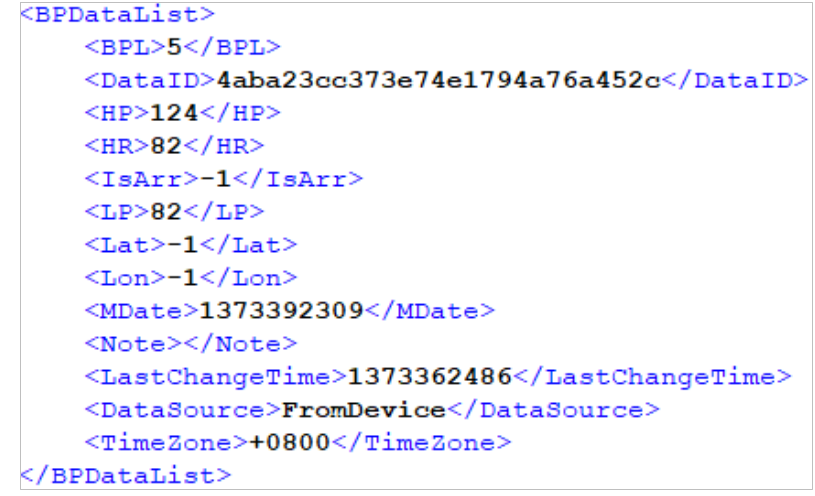
Figure 4. Data ingested from the iHealth Feel IoMT device